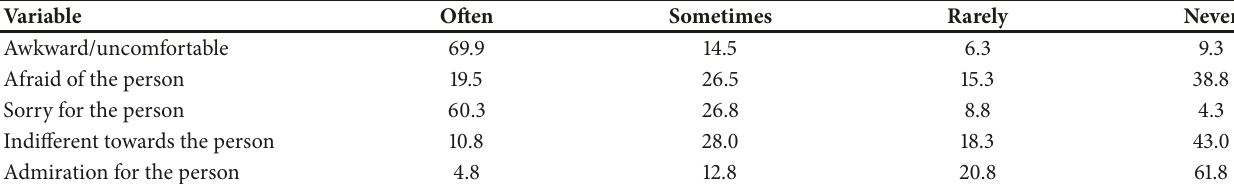
Table 3: Distribution of how respondents felt when they met pregnant women with disabilities.